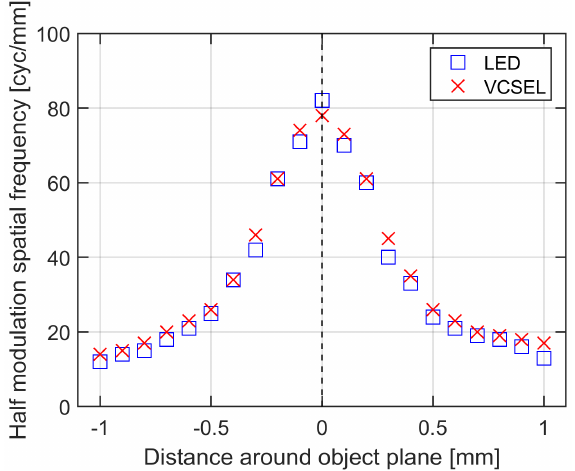
Figure 9. Depth of field measurements evaluated as the spatial frequency at half modulation as function of distance around the object plane. The modulation transfer function was measured via the knife edge method with both the LED and VCSEL light